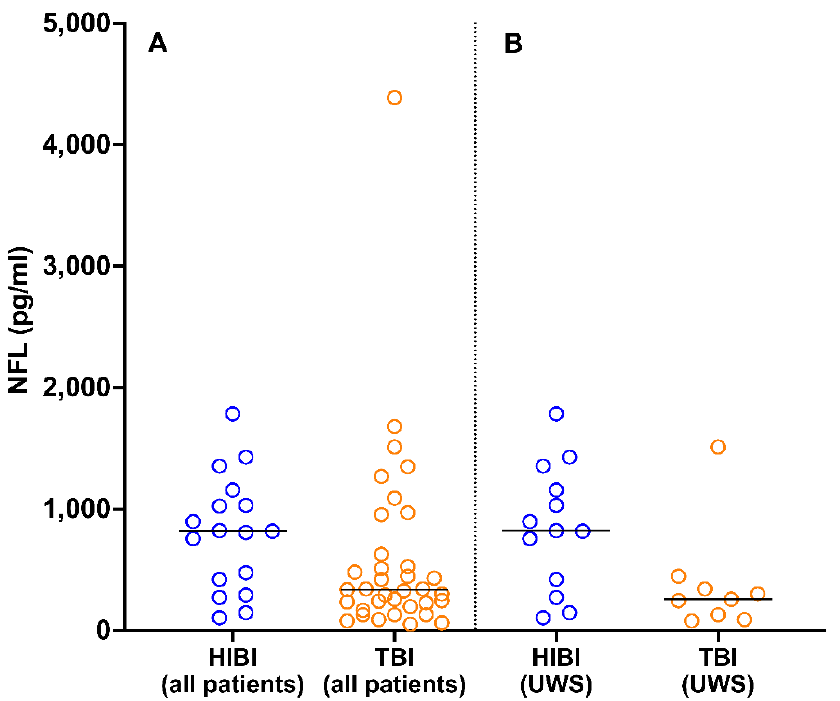
Figure 4. Distribution of NFL values 6 months post-injury in patients with HIBI and TBI in the total sample ( A ) and among patients with UWS ( B ). The horizontal lines indicate median values. NFL, neurofilament light chain; HIBI, hypoxic-ischemic brain injury; TBI, traumatic brain injury; UWS, unresponsive wakefulness